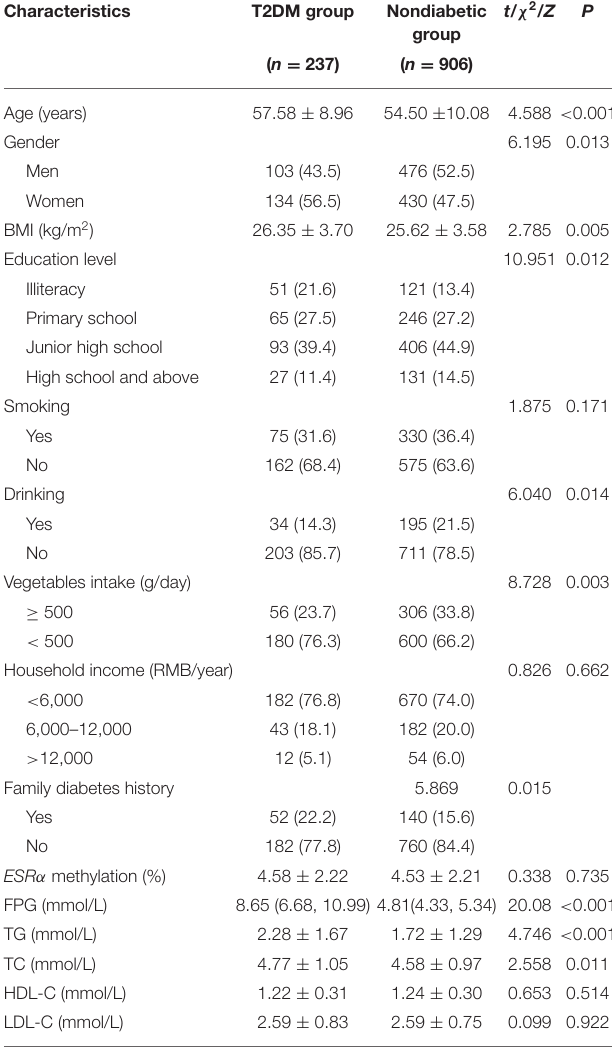
TABLE 1 | Characteristics of participants in T2DM group and Nondiabetic group a